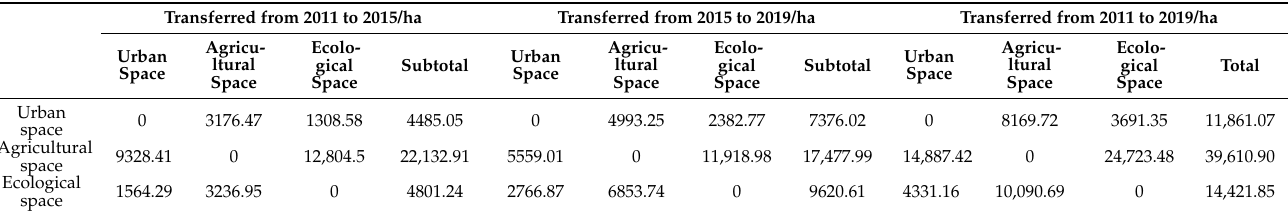
Table 2. Evolution of scale of UAE